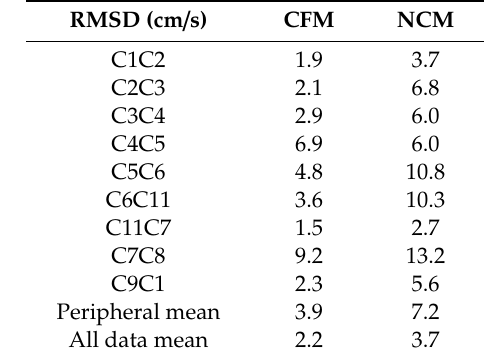
Figure 6. Hourly mapping ( a – l ) of the hourly-mean horizontal current fields calculated using the CFM (red arrows) and NCM (gray arrows). The observation time and the corresponding sea level height (red dot) are indicated in the lower-left and upper-right corners, respectively. Figure 7. Distribution of the 12-h mean residual current. The red and gray arrows indicate results obtained from the CFM and NCM, respectively.